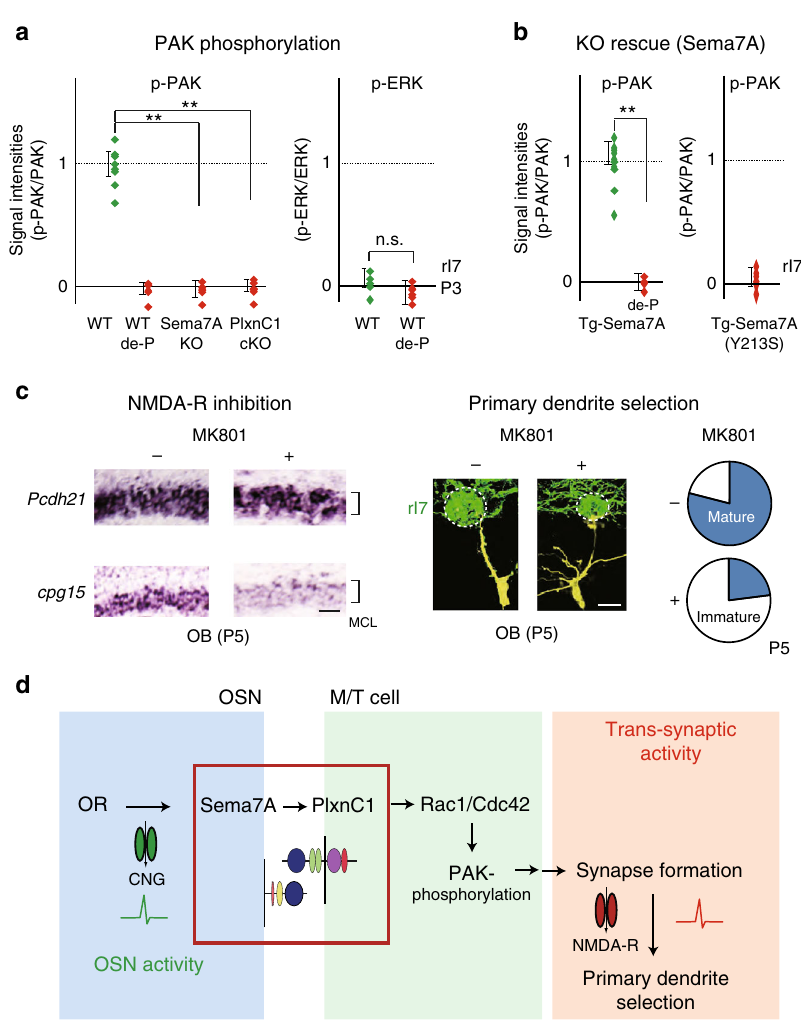
Fig. 8 Downstream of Sema7A/PlxnC1 signaling. a Signal cascades downstream of Sema7A – PlxnCl interaction. Left, Phosphorylation of PAK and ERK in the Sema7A KO and PlxnCl cKO. OB sections at P3 were immunostained with antibodies against phosphorylated form, and total proteins. Phosphatase-treated samples (de-P) were also analyzed. Relative fl uorescent intensities, p-PAK/PAK and p-ERK/ERK, are compared in the rI7 glomeruli. ** p < 0.01 (Student ’ s t - test). Error bars indicate SD ( n = 7, 3, 4, 5 glomeruli for WT, de-P, Sema7A KO, and PlxnC1 cKO). b Recovery of PAK- phosphorylation in the Sema7A KO by introducing the Tg Sema7A gene. This rescue is blocked by the Sema7A mutation, Y213S, which interferes with PlxnC1 interaction. By mating the transgenic animal, the WT or mutant Sema7A gene was introduced into the Sema7A KO mice, and was expressed constitutively in the rI7-expressing OSNs. OB sections at P3 were immunostained with antibodies against phosphorylated and total PAK. Phosphatase-treated samples (de-P) were also analyzed. Relative fl uorescent intensities p-PAK/PAK in the rI7 glomeruli are compared between the WT and mutant Sema7As. ** p < 0.01 (Student ’ s t - test). Error bars indicate SD ( n = 3 mice for the WT Sema7A, n = 2 mice for the mutant Sema7A). c Inhibition of the trans-synaptic activity in M/T cells. Left, Inhibition of the trans-synaptic activity with an NMDA-R inhibitor, MK801. OB sections at P5 were analyzed by in situ hybridization for the expression of Pcdh21 and cpg15 . EYFP-tagged rI7 glomeruli were identi fi ed by immunostaining. The expression of cpg15 (synaptic-activity marker) in M/T cells was inhibited after MK801 injection. n = 3 animals. Scale bar = 20 μ m. Right, Dendrite morphology of the MK801-treated M/T cells at P5. M/T cells were stained in yellow by LY injection into the rI7 glomeruli. The ratios (%) of mature (blue) and immature M/T cells in the rI7 glomeruli are shown: MK801 − , 19/25 (76.0 %); MK801 + , 6/25 (24.0 %). n = 19 glomeruli. Scale bar = 10 μ m. d Schematic diagram of synapse formation regulated by Sema7A signaling. OR-derived-neuronal activity induces Sema7A expression in OSNs. Sema7A interacts with PlxnC1 expressed in M/T-cell dendrites and activates the Rac1/ Cdc42-PAK signaling cascade to induce synapse formation. Trans-synaptic activities in M/T cells are responsible for dendrite selection and maturation. MCL, mitral-cell